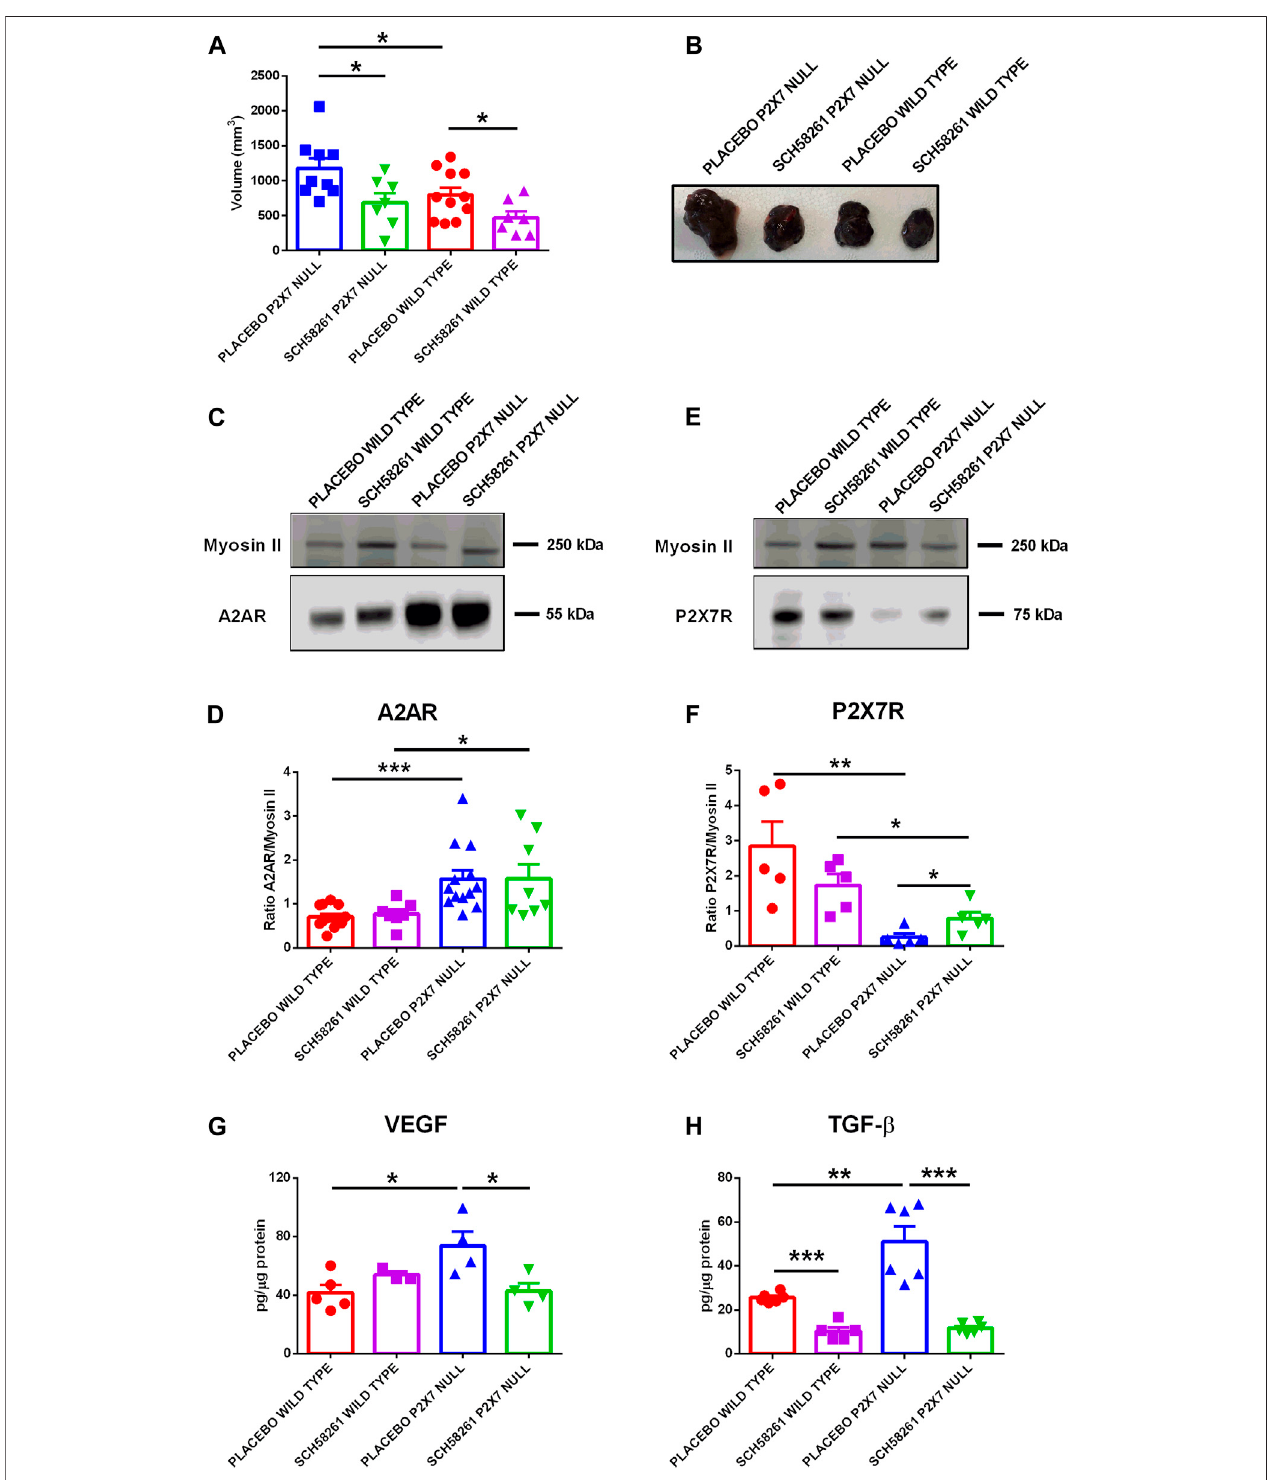
FIGURE4| C57bl/6micewereinoculatedintotheright fl ankwithB16-F10cellsinwildtypeandP2X7nullmice.A2ARantagonistSCH58261(1 mg/kg)orplacebo (sterile PBS containing 0.005% DMSO) were intra-peritoneum injected every 3 days after fi rst tumor mass detection (day 5 from inoculum). (A) Ex-vivo tumor volume assessed bycalliper. (B) Representativepicturesoftumors derivedfromtreatedwildtypeandP2X7nullmiceatpostinoculumday14( n =7 – 11pergroup). (C – F) A2AR (C) and P2X7R (E) expression by Western Blot and relative quanti fi cation (D,F) ( n = 5 – 13 per group). VEGF (G) and TGF- β (H) were evaluated in tumor masses obtained at post inoculum day 14 ( n = 3 – 6 per group). Data are shown as the mean ± SEM. * p < 0.05, ** p < 0.01 and *** p < 0.001.